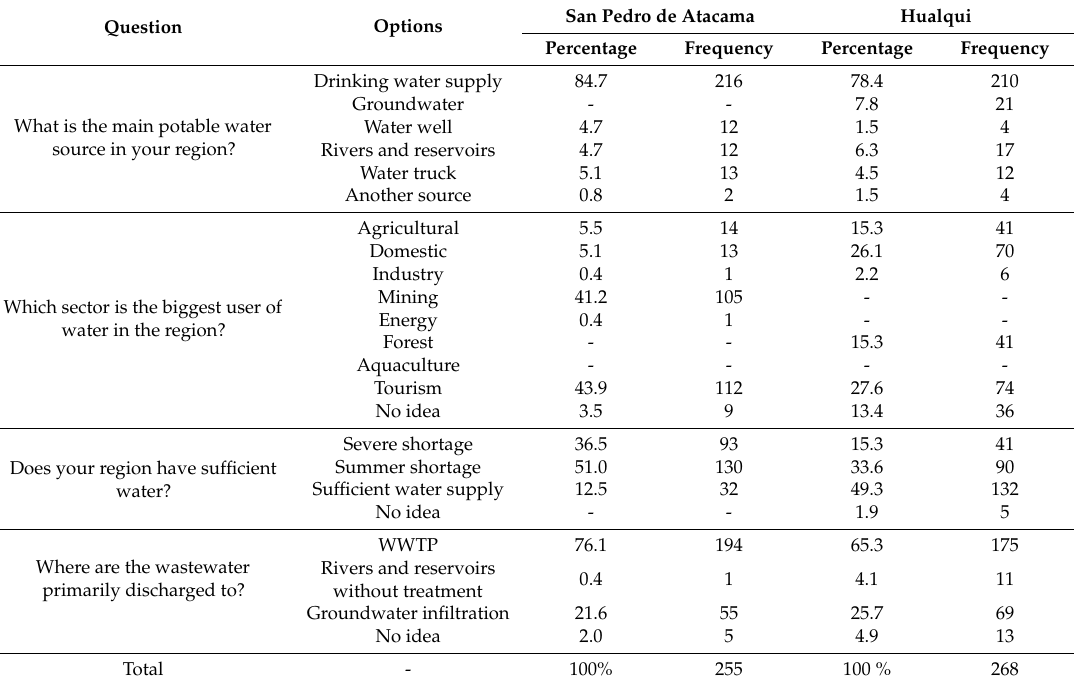
Table 4. Public knowledge with regard to water resources. .